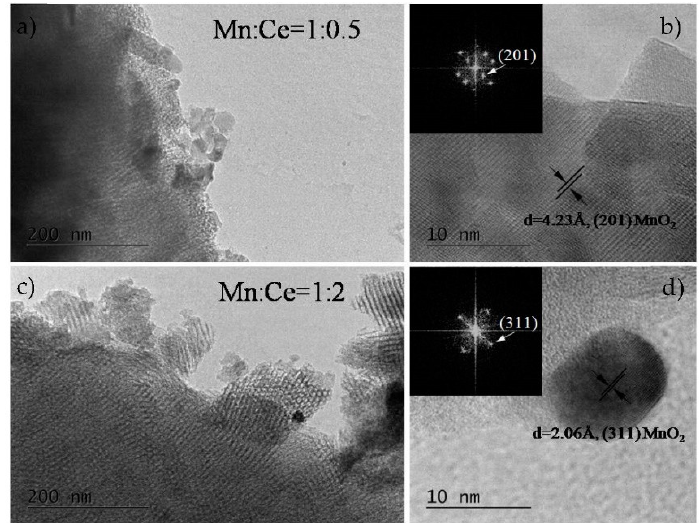
Figure 5. Bright field (BF) TEM ( a , c ) images at magnification 40,000× and HRTEM ( b , d ) images at magnification 600,000× of MnCe (1:0.5) and MnCe (1:2) catalysts, respectively.